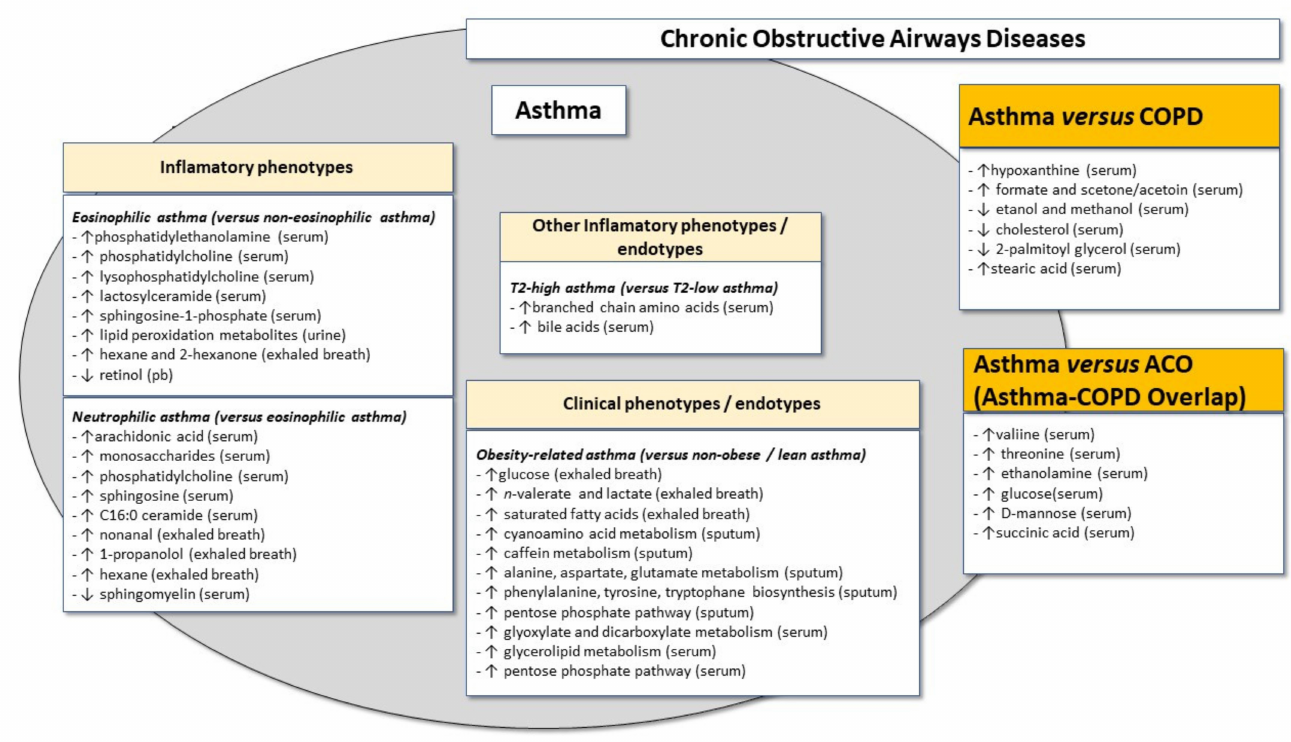
Figure 3. Representation of the main altered metabolic pathways and metabolites observed in metabolomics studies and their association with some of the most frequently analysed asthma phenotypes in adults. ACO—Asthma–COPD Overlap; COPD—chronic obstructive pulmonary disease; ↑ -increased; ↓